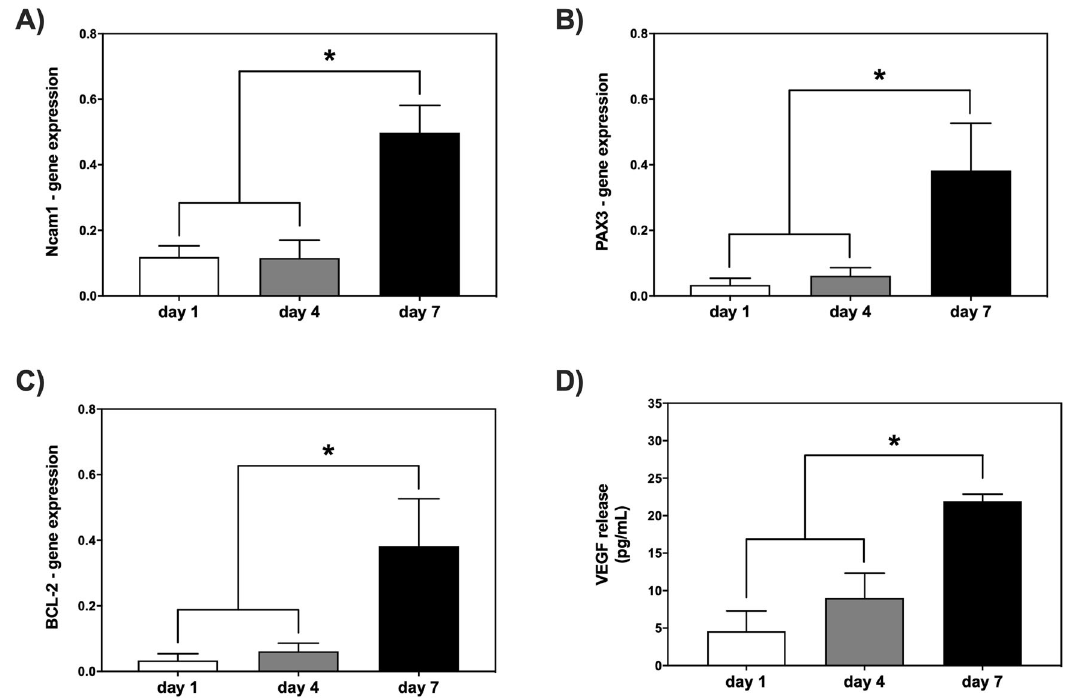
Fig. 5 Increased expression levels of Ncam1, Pax3, BCL-2 genes, and VEGF paracrine factor in myoblasts on day 7 after cell encapsulation. Quantitative real-time PCR analysis of Ncam1 ( A ), Pax3 ( B ), and Bcl- 2 ( C ) genes in total RNA extracted from myoblasts on days 1 (white bars), 4 (grey bars), and 7 (black bars) post-cell encapsulation ( n = 4 per group). Relative expression data are presented as mean ± SD of